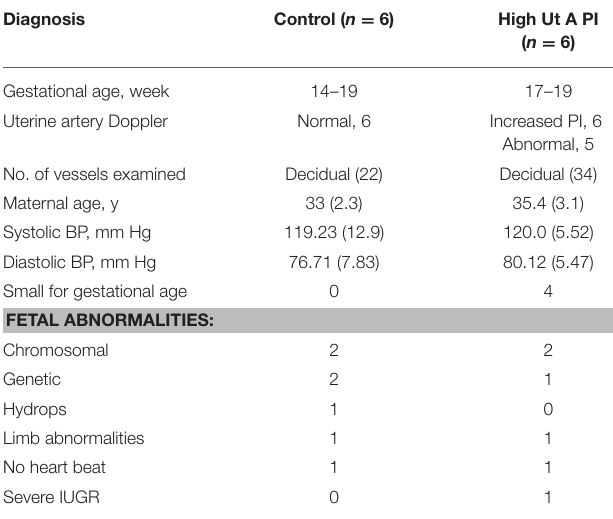
TABLE 3 | Patient demographics of the 2nd trimester decidua